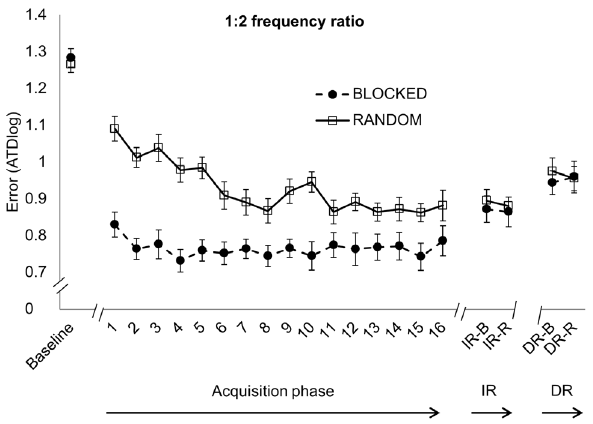
Figure 6. 1:2 frequency ratio. Error score (ATDlog, i.e. the log- transformed average target deviation) for baseline, acquisition phase (TR1-16), immediate retention (IR) and delayed retention (DR) (mean 6 standard error) learned under either a blocked (black circles) or randomized (white squares) practice schedule. Better performance is indicated with lower levels of ATDlog.